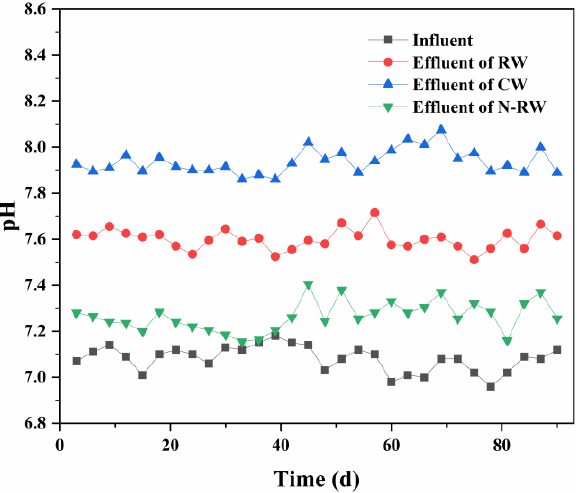
Figure 6. Changes of pH in influent and effluent of three groups of wetland systems.